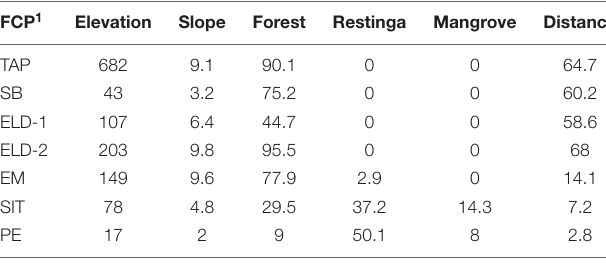
TABLE 2 | Field collection points and environmental